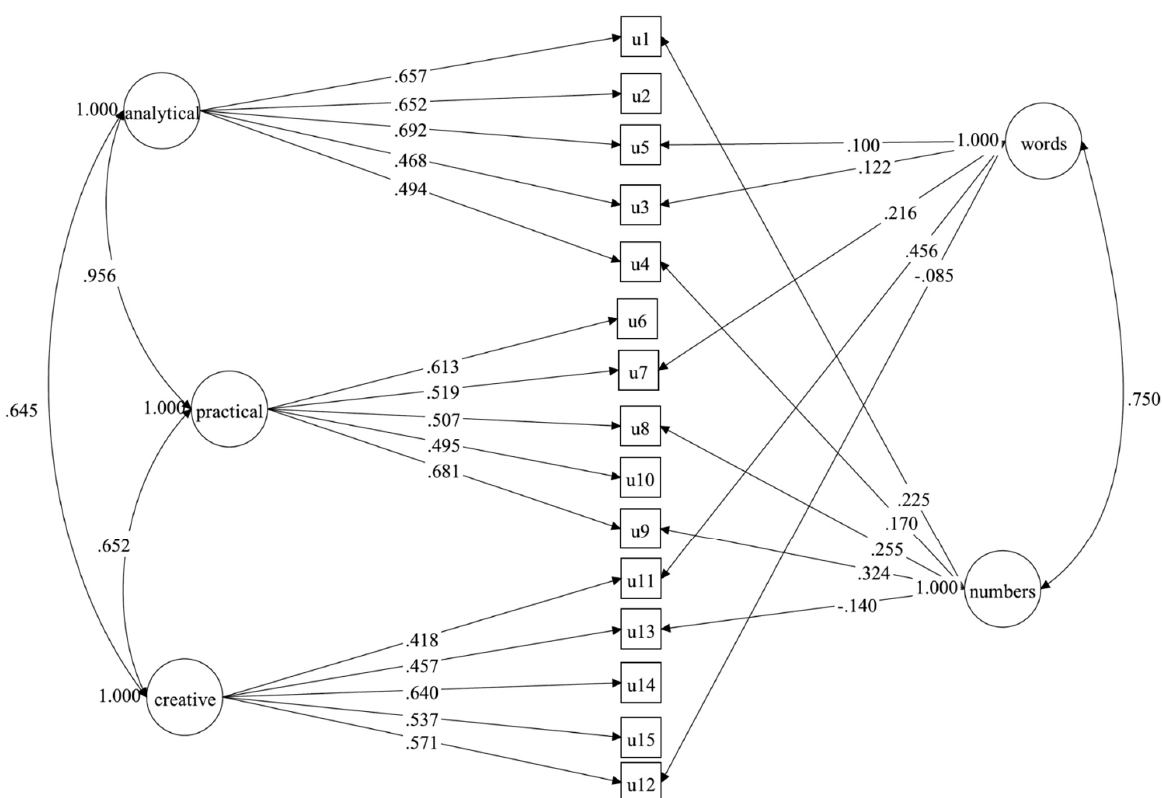
Figure 3. Model 3: CT-C(M-1) model. Notes. u1 = Story Problems, u2 = Floating Boats, u3 = Metaphors, u4 = Number Cards (Letter Math), u5 = Words That Sound the Same (Homophones), u6 = Paper Cutting, u7 = Decisions, u8 = Maps, u9 = Exchange, u10 = Toy Shadows, u11 = Interesting (Figurative) Language, u12 = Conversations, u13 = Number Talk, u14 = Multiple Uses, u15 = Book Covers. Table 3. Fit statistics for alternative factor models of the Aurora Battery (N = 2007).